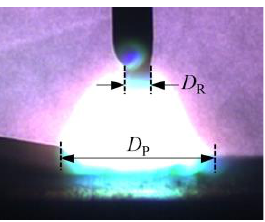
Figure 4. Schematic diagram of arc profile dimensions.